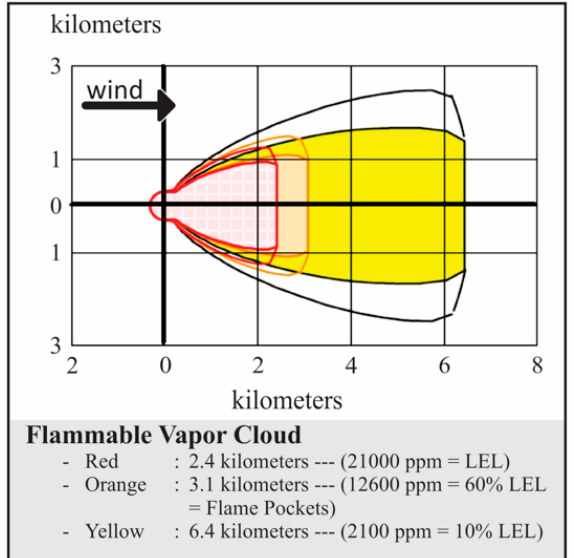
Figure 4. ALOHA simulation result for scenario S13 catastrophic rupture of Horton sphere.